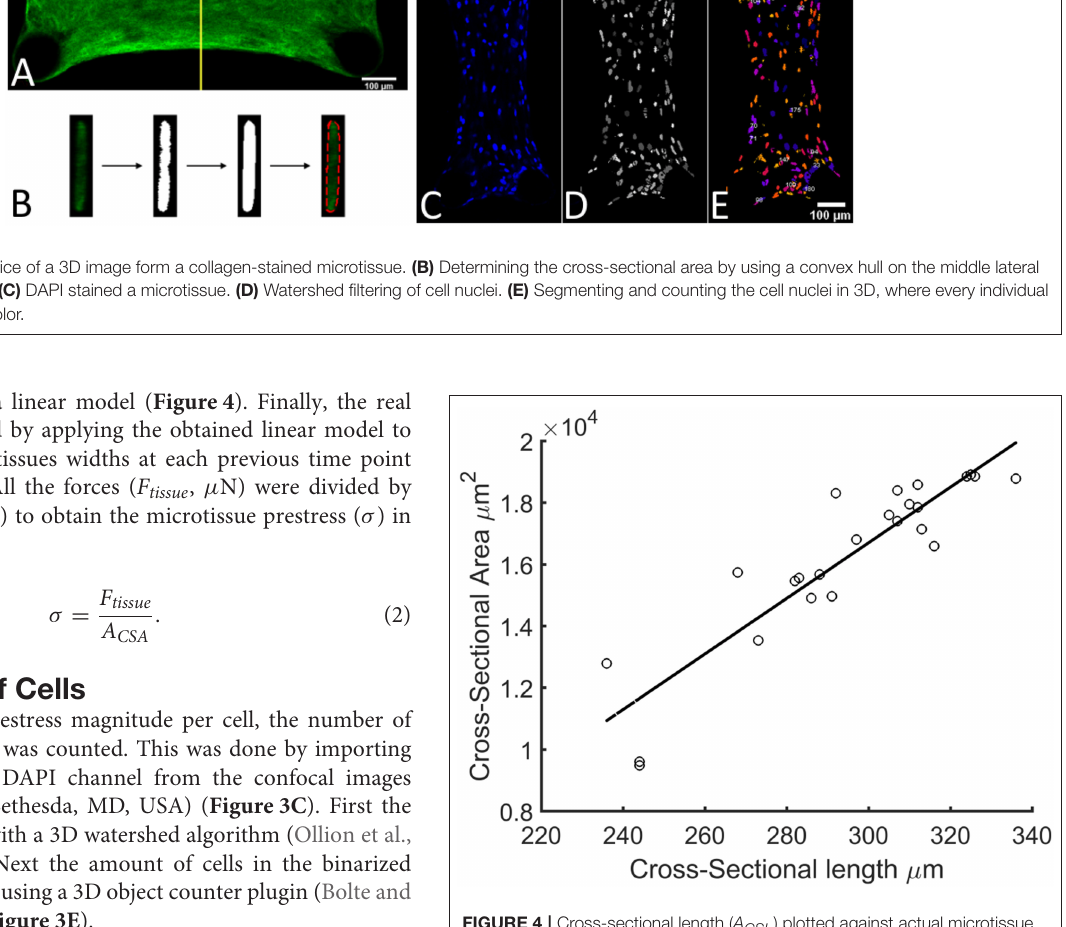
FIGURE 4 | Cross-sectional length ( A CSL ) plotted against actual microtissue CSA A CSA . The black line is the fitted linear model with equation: A CSA =90.09* A CSL -10323.41 ( R 2